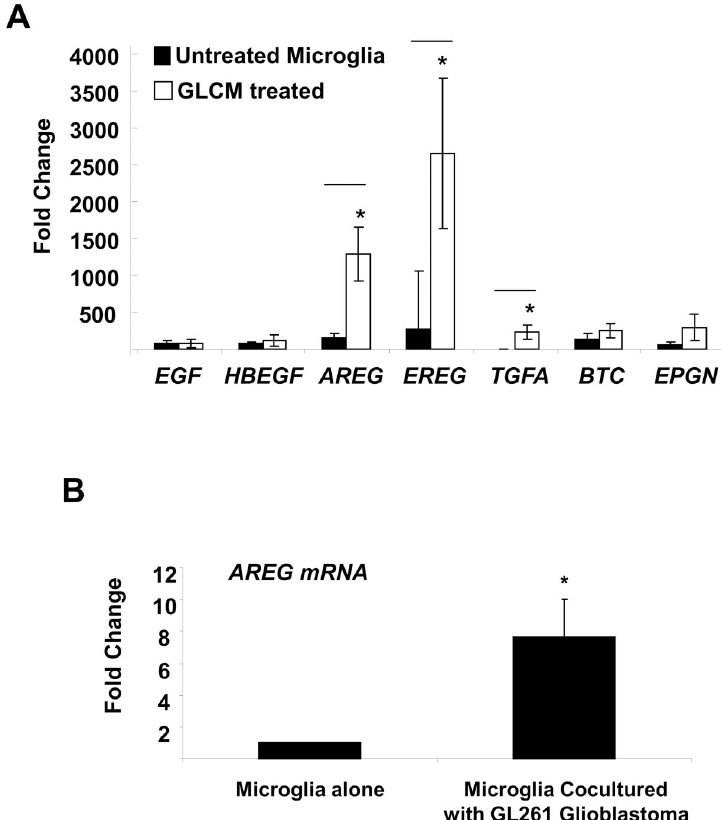
Fig 1. EGFR ligand gene expression induced in microglia by glioma cells. (A) Conditioned media harvested from GL261 cells was used to treat microglia overnight. Quantitative RT PCR was performed using the primers indicated. Data shown are ^2 -delta delta ct relative to GDH control. � : P < .05. (B) GL261 cells were cocultured with microglia for 24 hours followed by cell sorting, RNA isolation and qRTPCR analysis using the AREG primers. Results are an average of 8 independent experiments � : P <